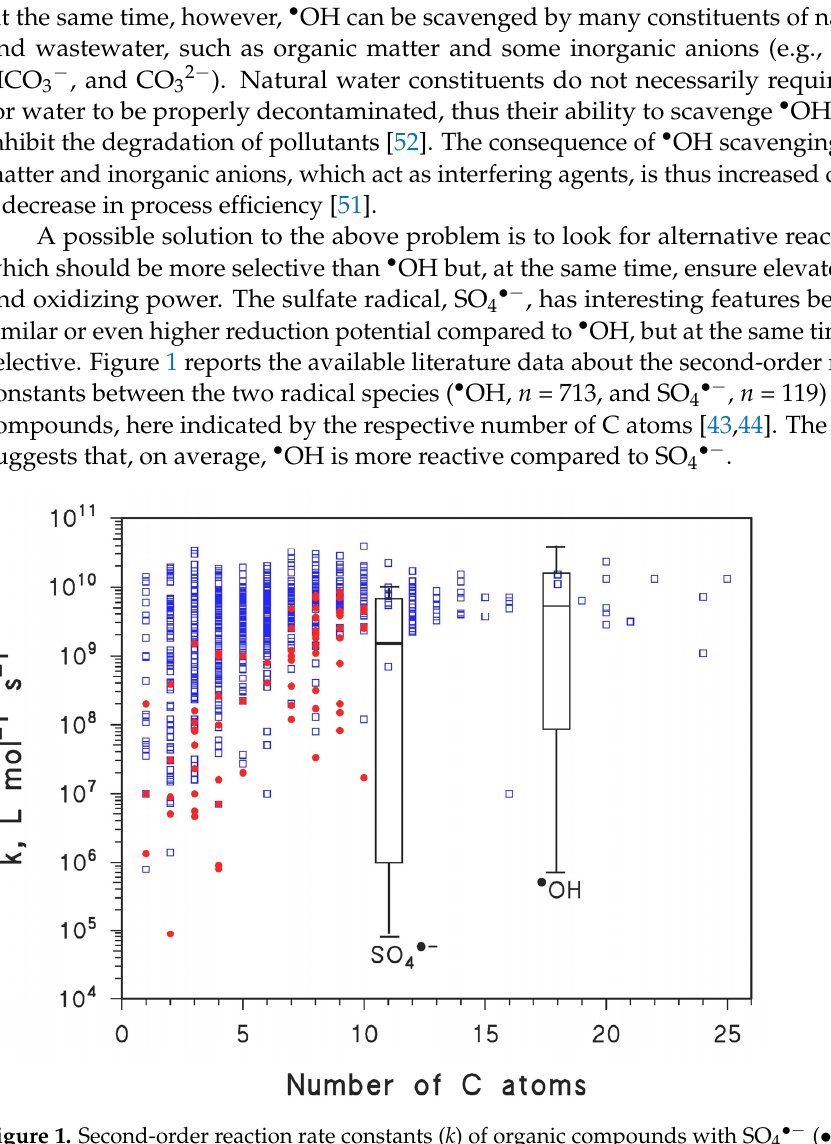
Figure 1. Second-order reaction rate constants ( k ) of organic compounds with SO 4• − (•, n = 119)